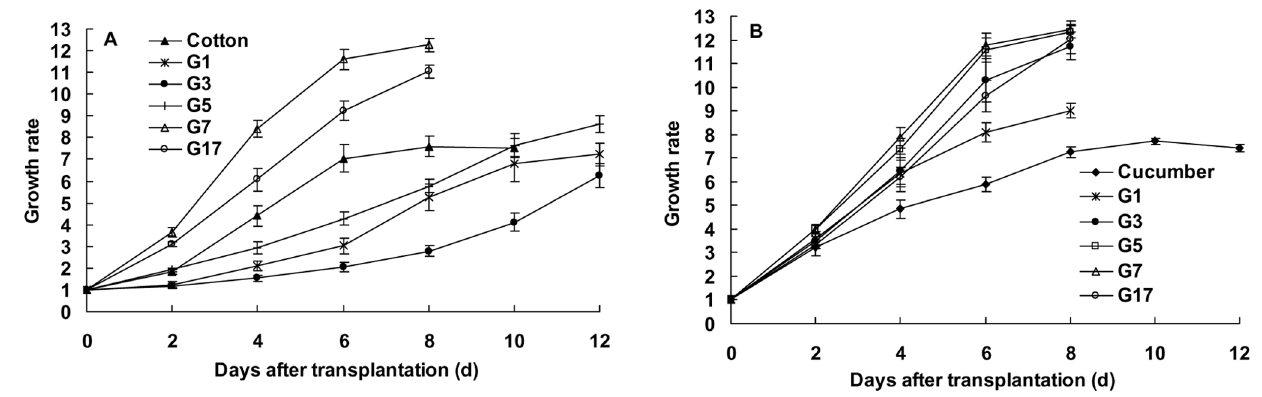
Figure 2. Growth rates of the cotton-specialized aphids (A) and cucurbits-specialized aphids (B) on zucchini for different generations (G1–G17). Bars are means 6 1SE.